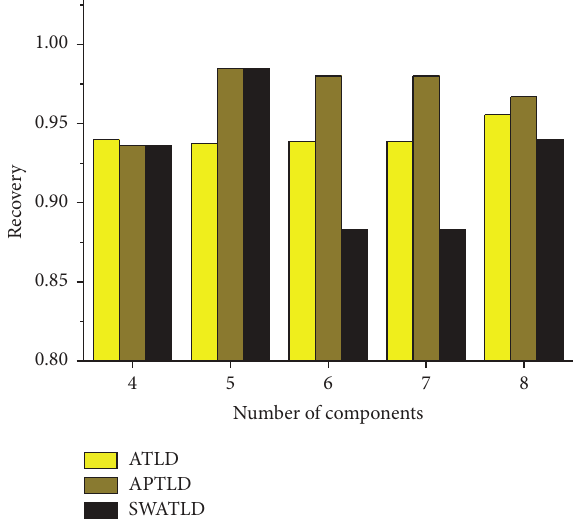
Figure 5: Comparison of the mean values of COS corresponding to three different algorithms and a varying number of components.